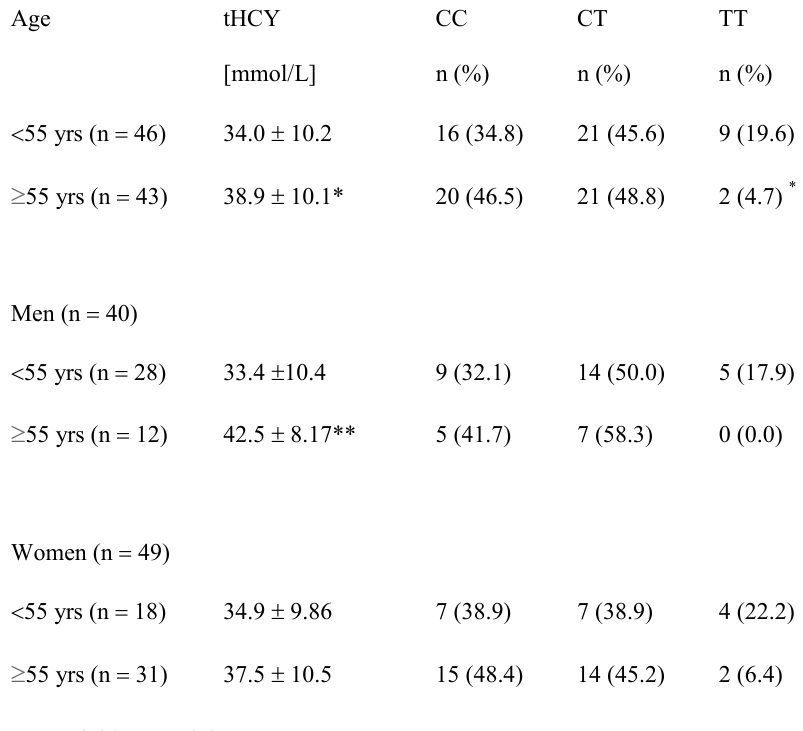
Table 1. Serum concentration of total homocysteine (tHCY) and polymorphism of methylenetetrahydrofolate reductase (MTHFR) by sex and age in patients with cardiovascular